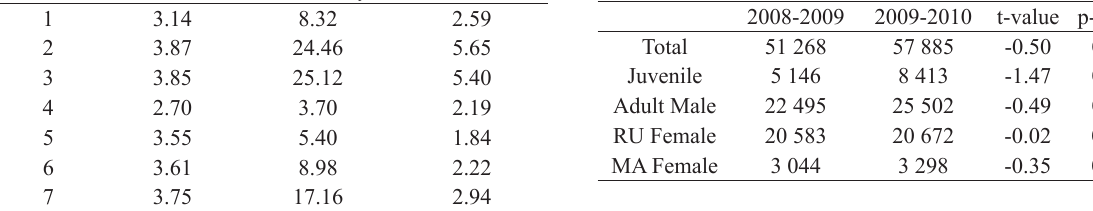
The mean values of sediment texture (Phi), percentage of silt and clay, and organic matter content (O.M.) for each sample location in the São Vicente Estuary (1-4) and in the Santos Bay (5-8) from May 2008 through April 2010. Location Phi % silt+clay % O.M.